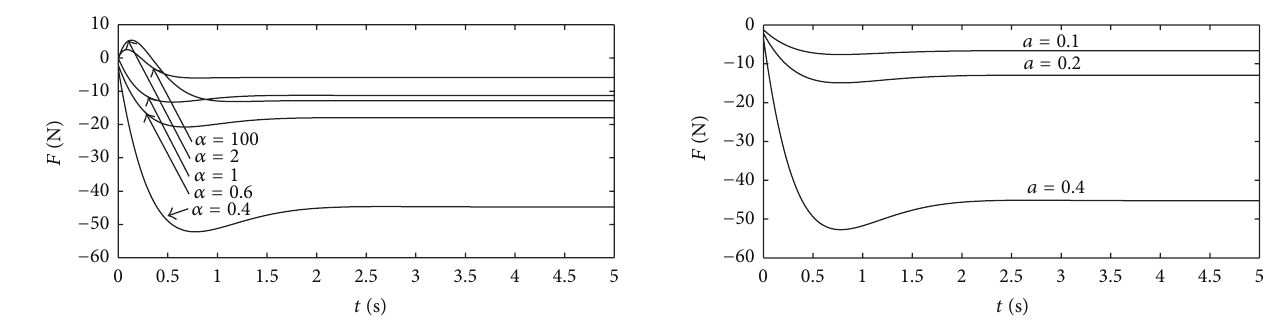
Figure 2: The influence of the loading ratio on the dynamic tension ( 𝜉 = 0.8 , 𝑎 = 0.4 m / s): (a) 𝛼 = 0.4 ; (b) 𝛼 = 0.6 ; (c) 𝛼 = 1 ; (d) 𝛼 = 2 ; (e) 𝛼 = 100 .